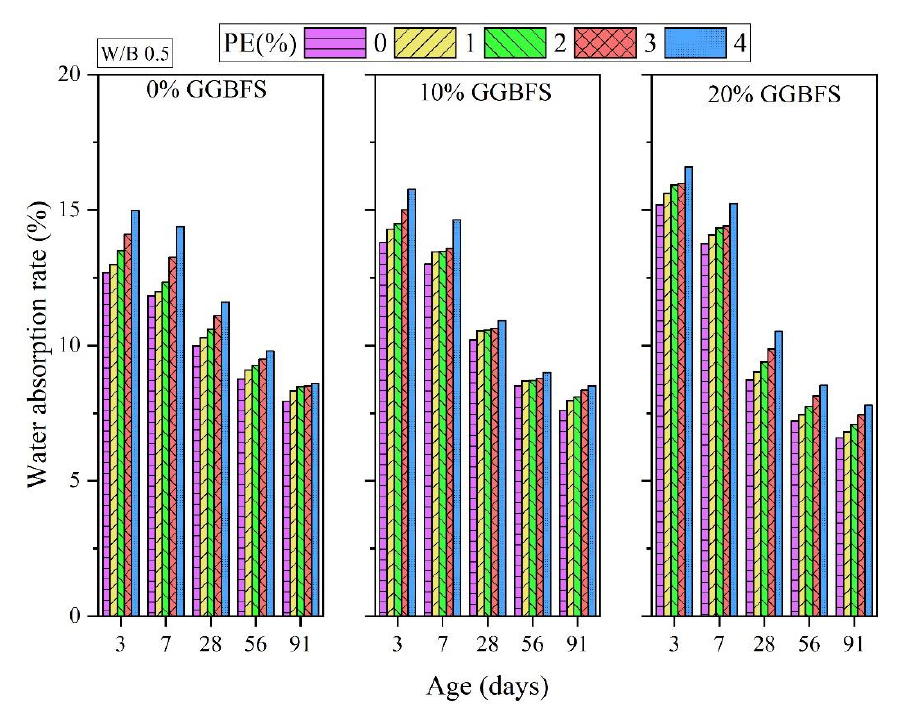
Figure 10. The water absorption rate of cement mortars with the addition of different ratios of waste PE and GGBFS replacement.